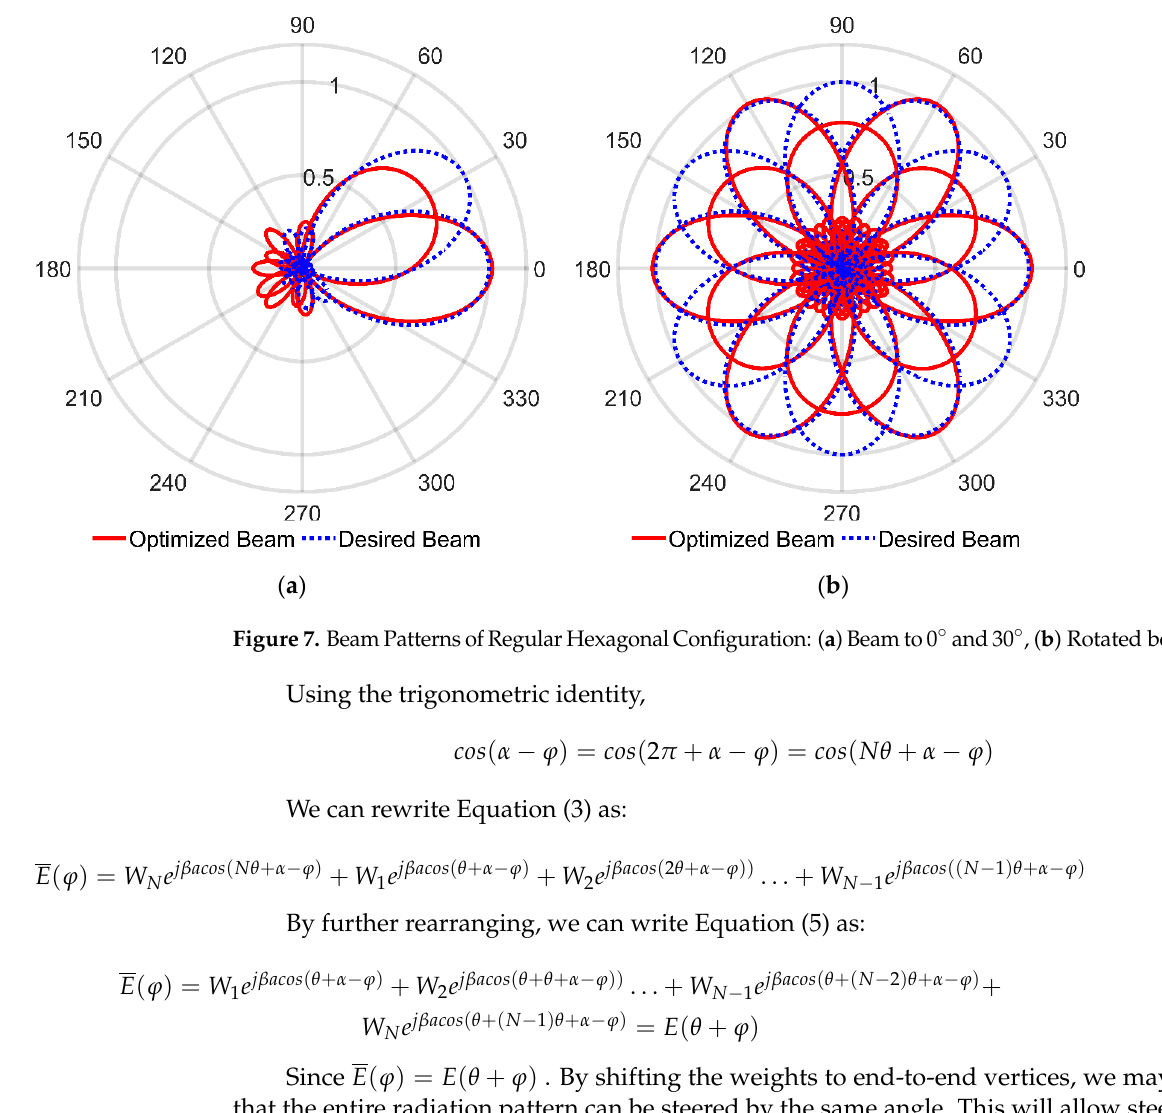
Figure 6. Schematic diagram of dipole placement in a regular polygon.